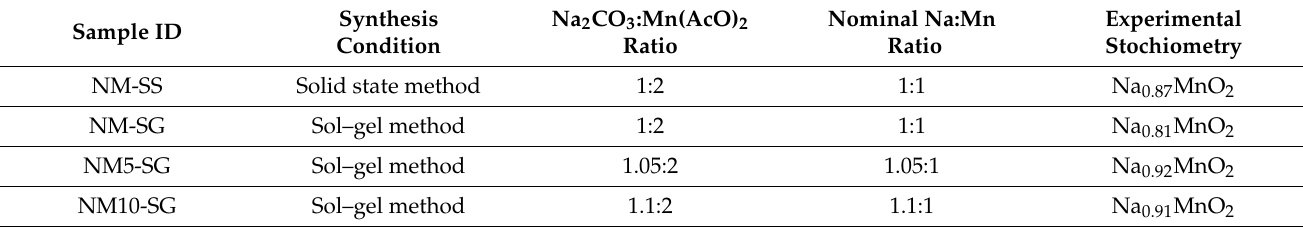
Table 2. A summary of the samples synthesized, their synthetic methods and their experimental stoichiometries obtained by